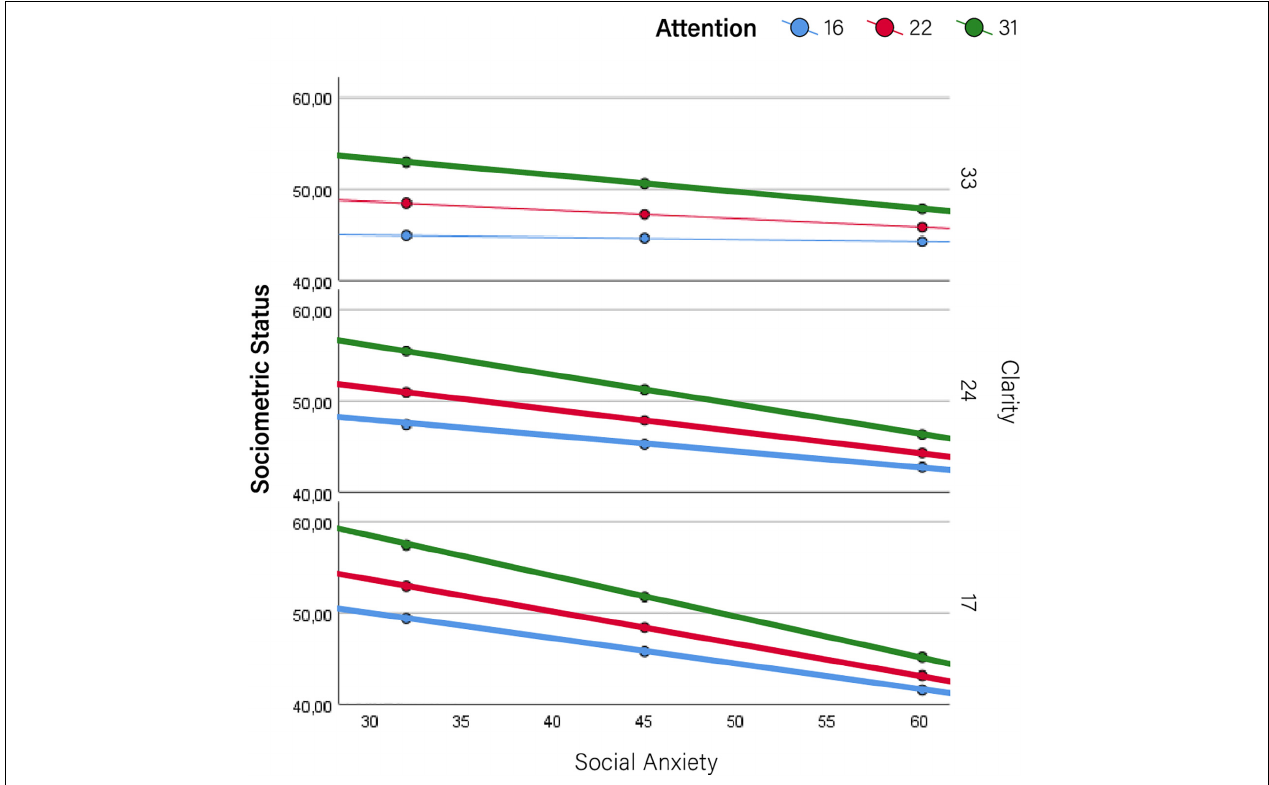
FIGURE 3 | Moderator effects of self mentalizing dimensions on sociometric status. Conditional effects of social anxiety on sociometric status at different levels of attention to emotions and emotional clarity.